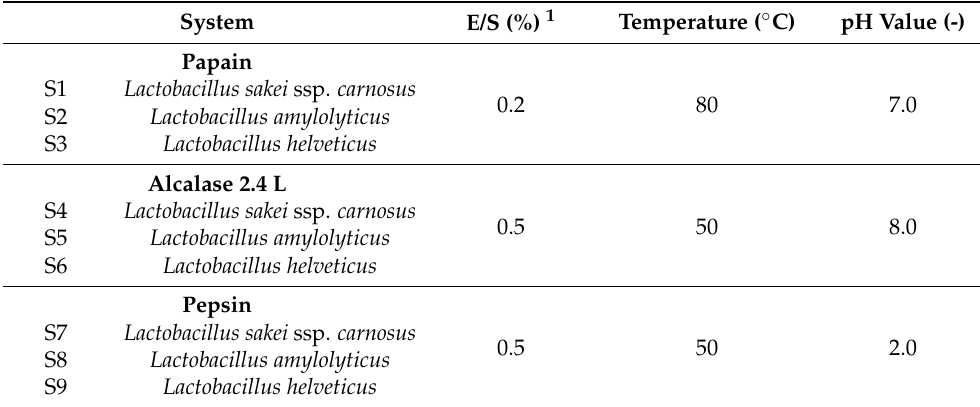
Table 2. Experimental design of enzymatic hydrolysis and fermentation with enzyme-to-solution ratio (E/S), temperature and pH value of enzymatic